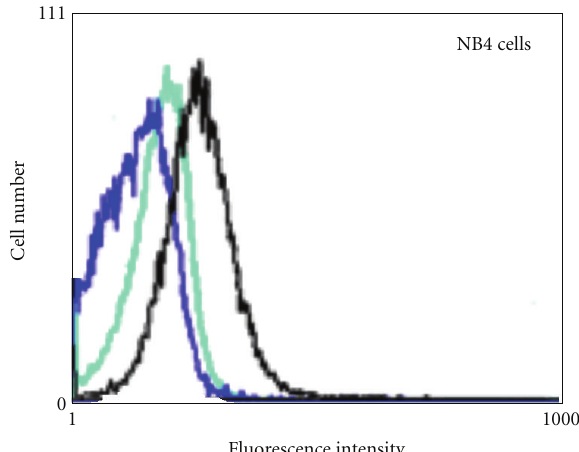
Figure 1: Detection of plasminogen bound to the surface of NB4 cells. Cells (5 × 10 5 ) were washed with PBS containing 1% BSA and 0.1% sodium azide (PBA) and incubated with 10 μ M plasminogen (black tracing) or bu ff er (blue tracing) for 1 hour at 37 ◦ C, washed again and incubated with PBA containing 10% heat-inactivated normal rabbit serum for 10 minutes a room temperature. As an additional control, NB4 cells were treated with carboxypeptidase B (200U/mL) before adding plasminogen (teal tracing). After incubation, supernatants were removed by centrifugation, incubated with mAb49 (130 nM) for 30 minutes a 4 ◦ C, washed and then stained with FITC-goat anti-mouse IgG, which was detected by FACS analyses. This research was originally published in